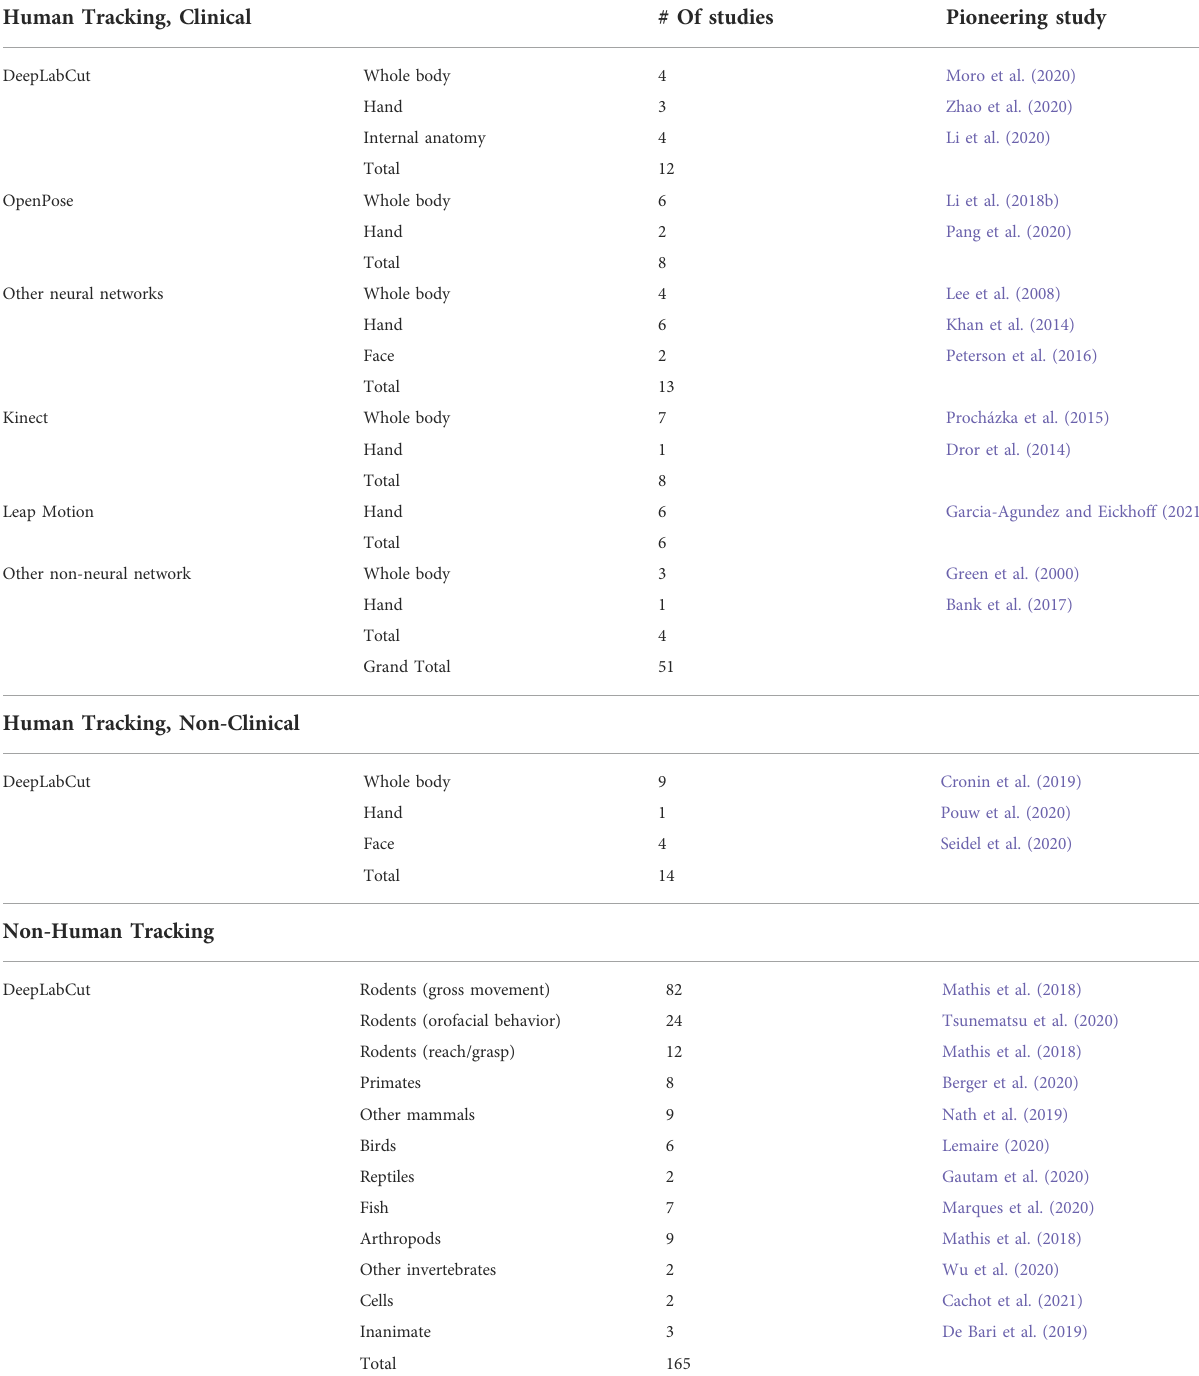
TABLE1Enumerationofmarkerlessmotiontrackingstudiesintheliterature.DeepLabCut(DLC)studieswereidenti fi edbysearchingforarticlesciting the initial DLC publications (Mathis et al., 2018; Nath et al., 2019) using Google Scholar. The Kinect (Microsoft) and Leap Motion controller (Ultraleap) are consumer markerless motion tracking devices that do not utilize deep learning. For the “ Human Tracking, Non-Clinical ” and “ Non- Human Tracking ” categories, only studies which utilized DLC were enumerated; studies using other markerless motion tracking methods were excluded for